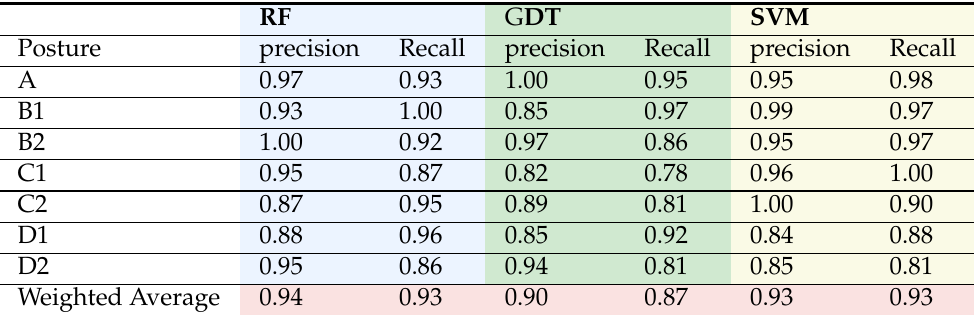
Table 3. Recall and precision for each class and overall weighted precision and recall of the trained models. Colour: blue columns show result for the RF classifier, green columns show result for the GDT classifier, and yellow columns show result for the SVM classifier. The red row shows the overall weighted average for precision and recall for each